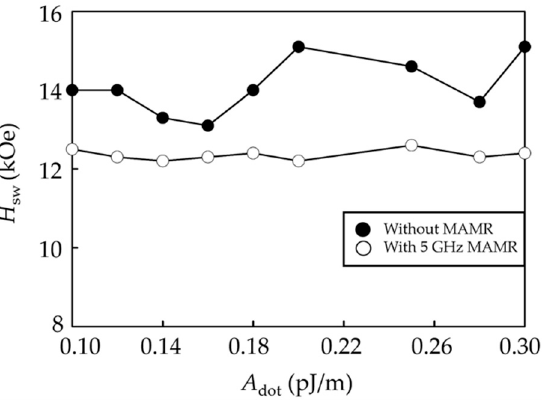
Figure 3. H sw of the bilayer ECC - BPM with and without HAMR as a function of A dot . In a case without MAMR, the media with higher A dot tend to have higher H sw . A the media. This interaction indicates an interacting force between adjacent